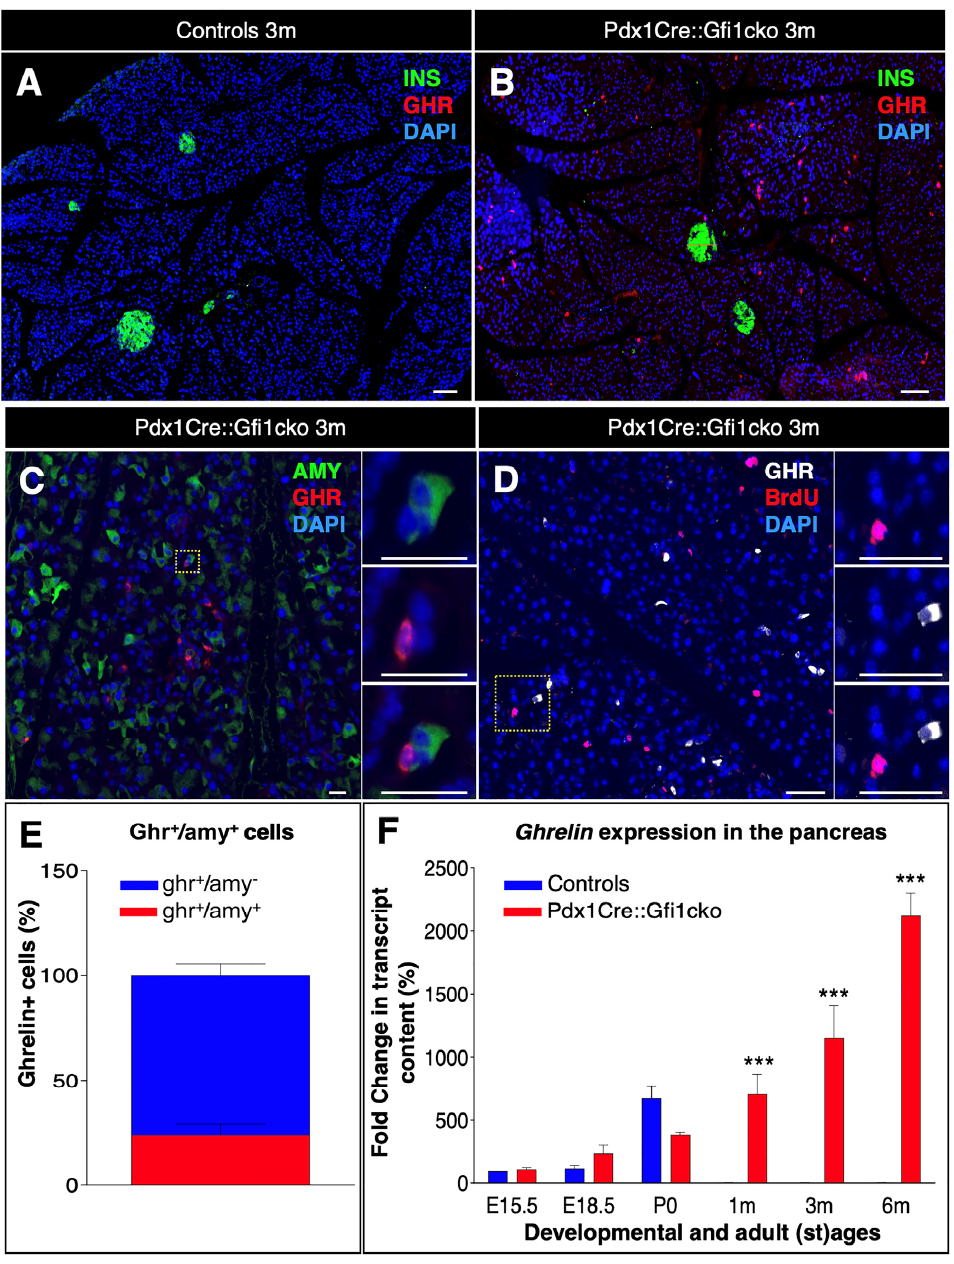
Figure 4. Ghrelin is misexpressed in Pdx1Cre::Gfi1cko adult pancreas.